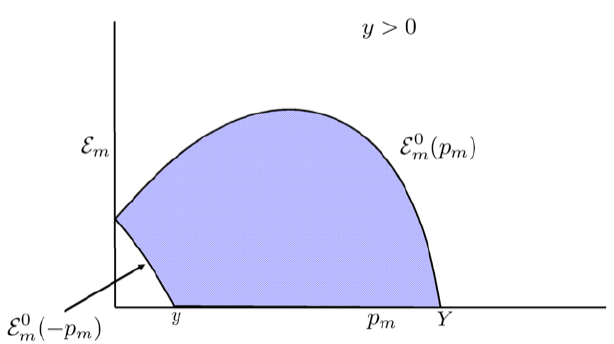
Figure 3. Physically allowed region for the situation where y > 0. The upper boundary labeled E 0 ( p m ) has cos θ m = 0 whereas that labeled E 0 m are discussed in the text; figure from